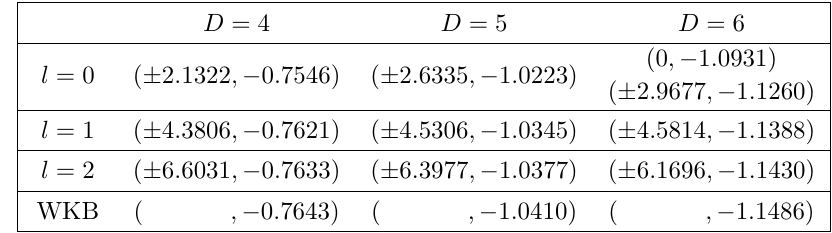
with q = 0, (cid:3) (cid:20) (cid:0)